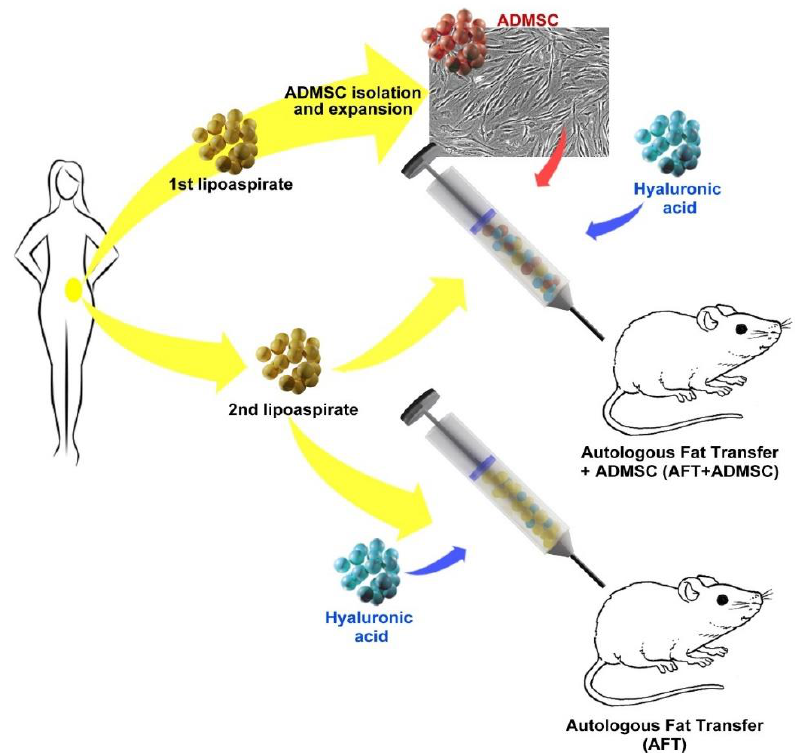
Figure 2. Transplantation approach: Engraftment in vivo was performed according to the autologous fat transfer (AFT) method with/without cells. The AD-MSCs were isolated and expanded from a first lipoaspirate and combined with autologous fat (second lipoaspirate) obtained from the same patient; for the in vivo engraft for cell tracking studies, AD-MSCs were genetically modified by GFP viral vector (AD-MSC-GFP); AFT alone was performed as a control by implantation of only lipoaspirate derived from the same donor, and hyaluronic acid was added as a carrier.